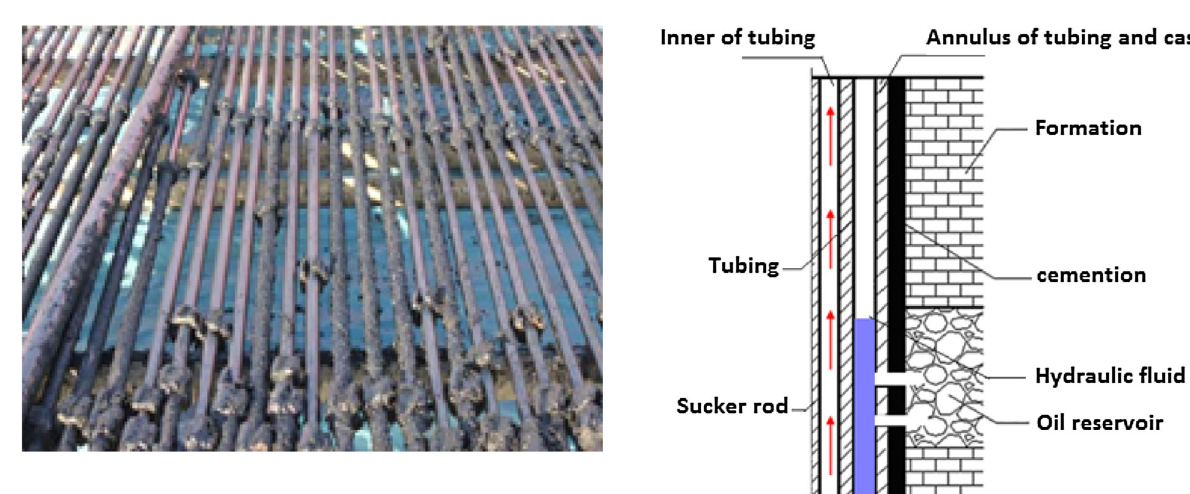
Fig. 1 Wax of tubing and sucker rod